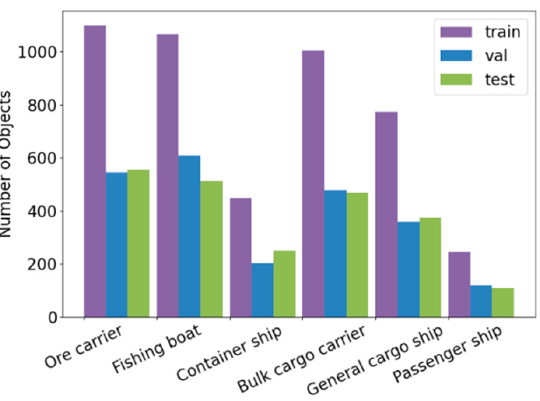
Figure 5. Distribution of six categories of ships in training set, verification set and test set.